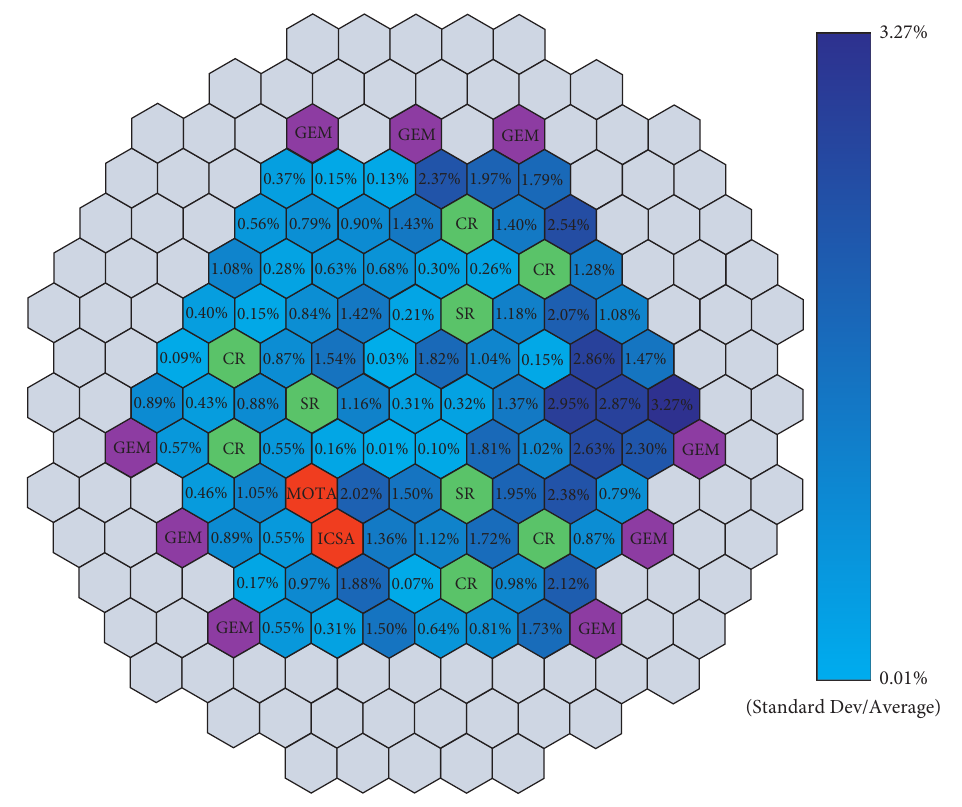
Figure 12: Power distribution calculation variation coefficient map of FFTF core.